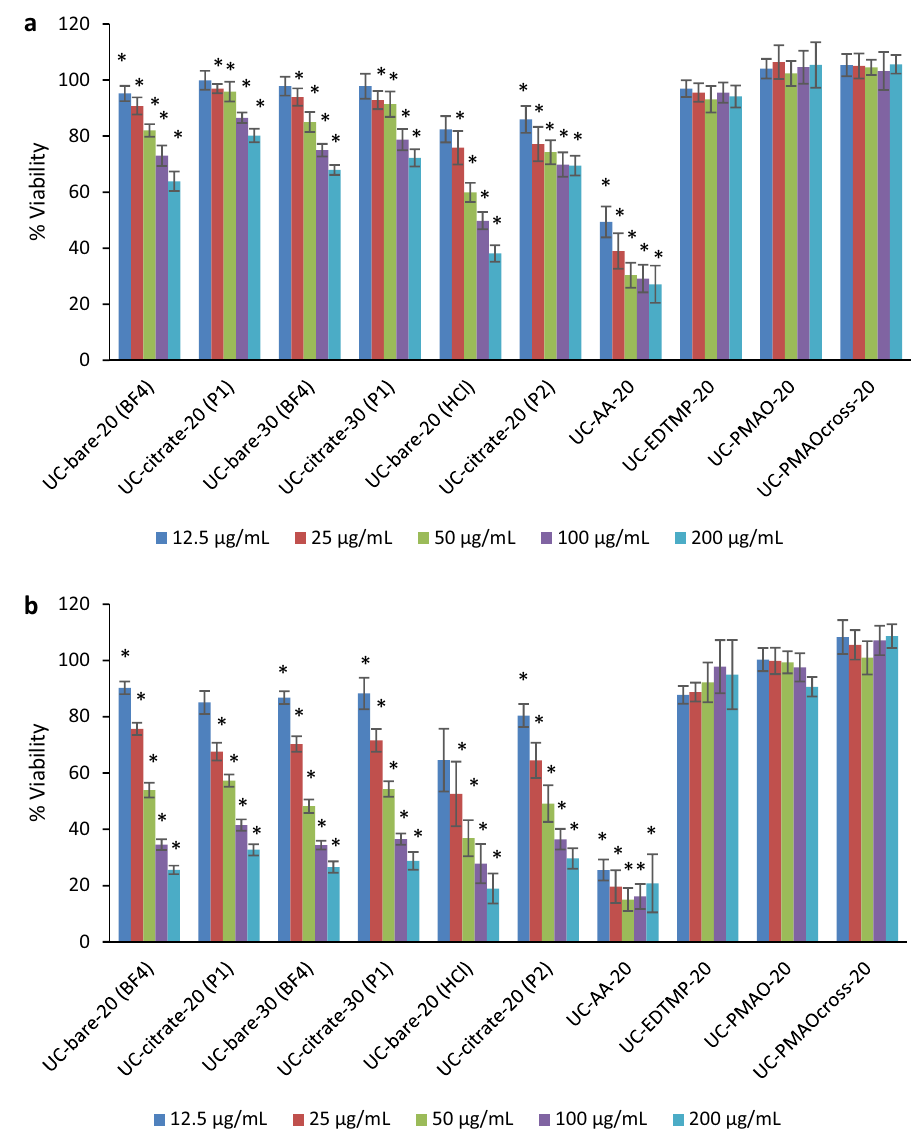
Figure 4. Viability of HaCaT cells after exposure to UCNPs with different surface coatings for ( a ) 24 h and ( b ) 48 h: UC-bare-20 (BF4); UC-citrate-20 (P1); UC-bare-30 (BF4); UC-citrate-30 (P1); UC-bare-20 (HCl); UC-citrate-20 (P2); UC-AA-20; UC-EDTMP-20; UC-PMAO-20; UC-PMAOcross-20. The results are reported as mean ± standard deviation (SD) of 4 technical replicates in each of the 3 independent experiments for 24 h and 48 h. * indicates significant statistically differences compared to the control (p <